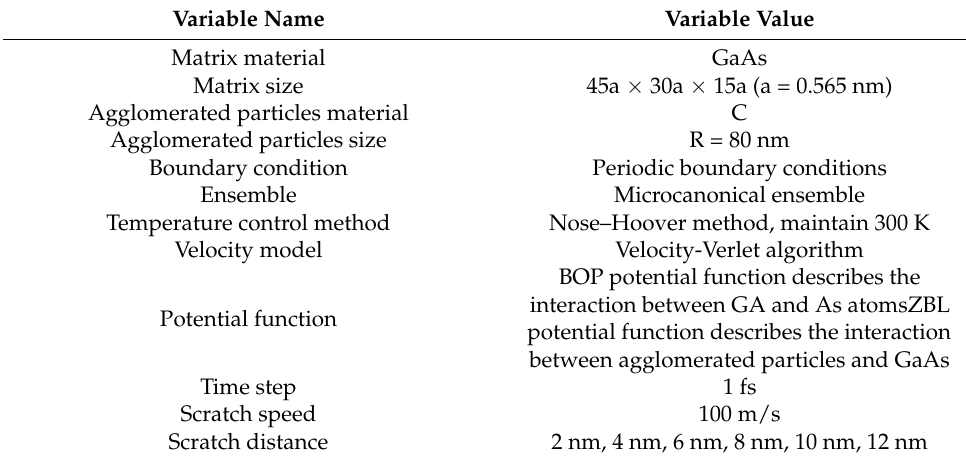
Figure 2. Scratch movement between agglomerated particles and workpiece surface. Table 1. Parameters applied in the simulation model .